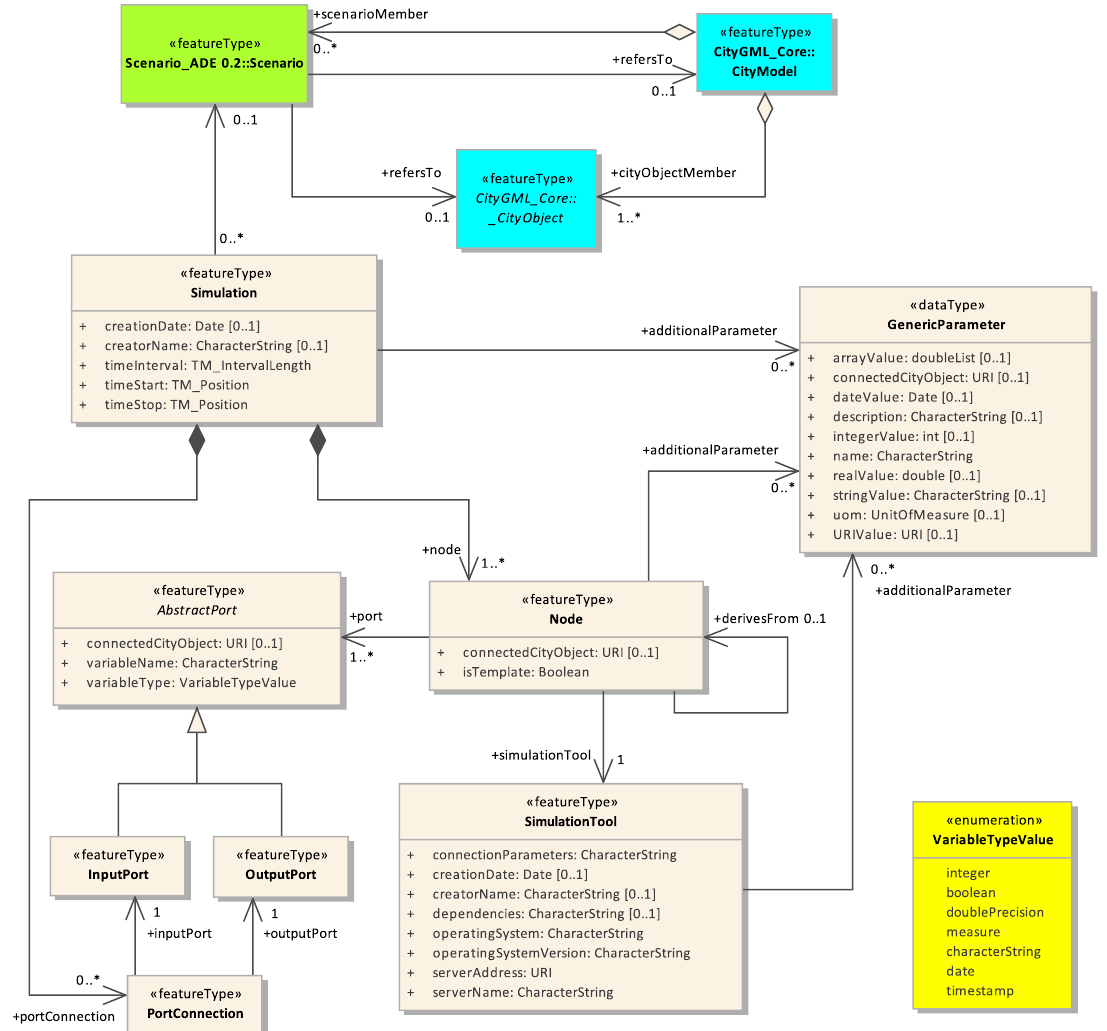
Figure 1. UML diagram of the Simulation Package: its classes are depicted in light beige, while the azure ones belong to the CityGML data model and the green one to the Scenario